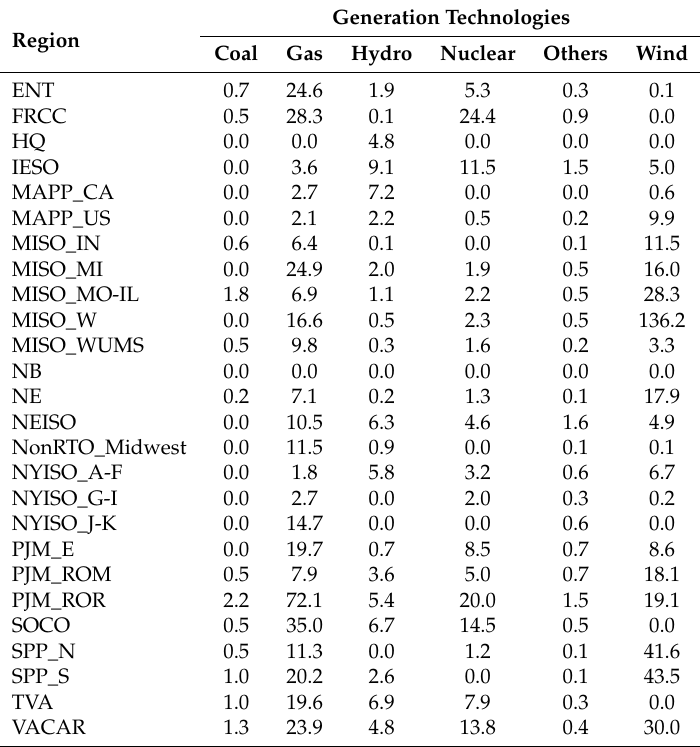
Table 1. Final generation capacity values